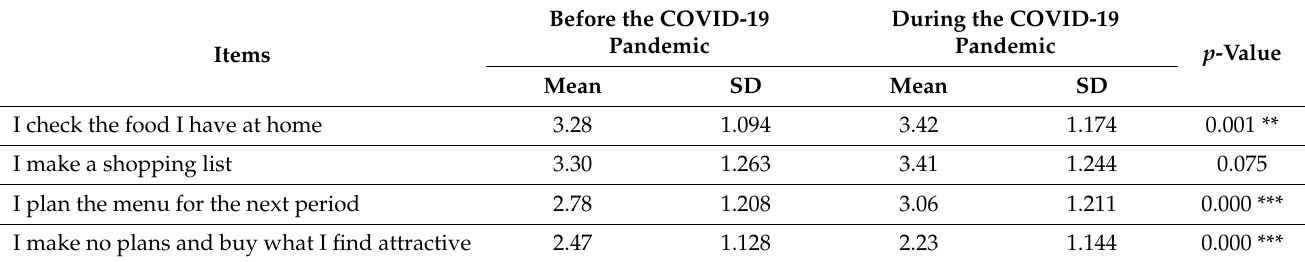
Figure 2. Comparative analysis of shopping habits. Table 3. Shopping habits before the COVID-19 pandemic and during the COVID-19 pandemic.